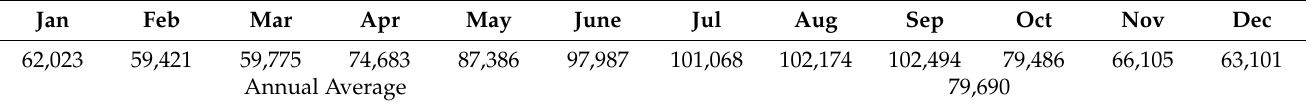
Table 8. Monthly average electricity demand in MW—calculated by EnergyPLAN for RE2040.